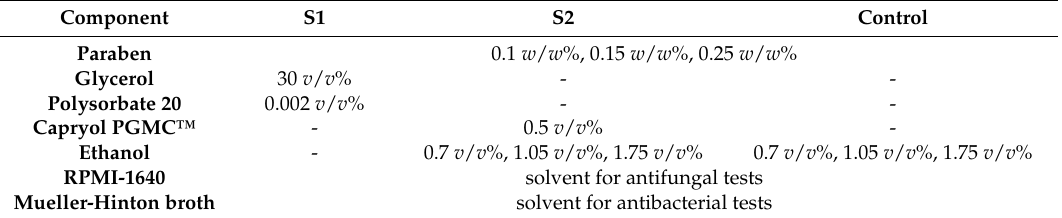
Table 2. Composition of test solutions for antimicrobial